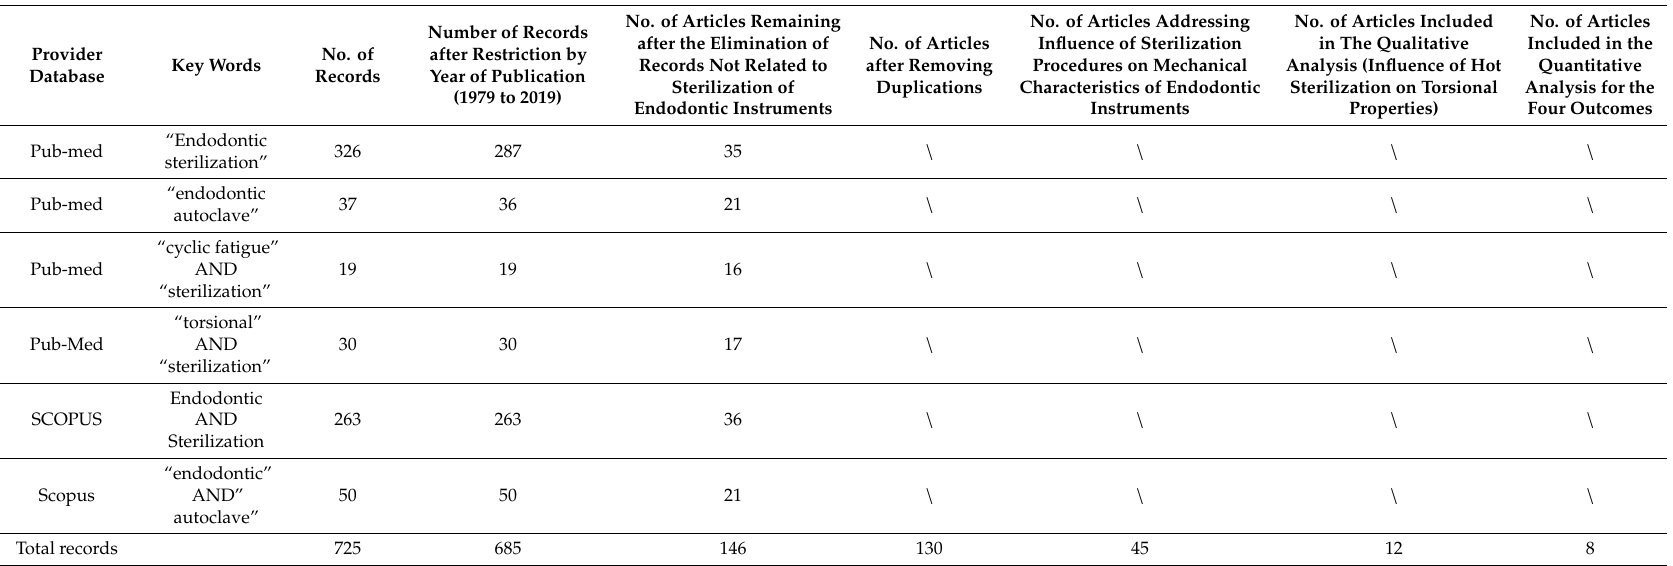
Table 1. Complete overview of the search methodology. Records identified by databases: 725; records selected for qualitative analysis: 12; records selected for quantitative analysis: